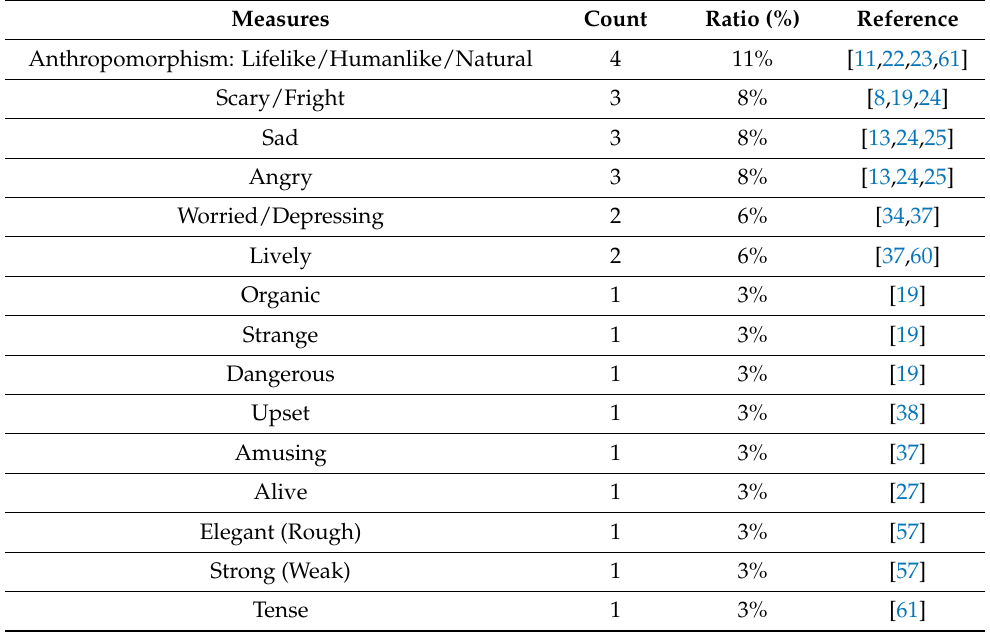
Table 7. Appearance of a robot.